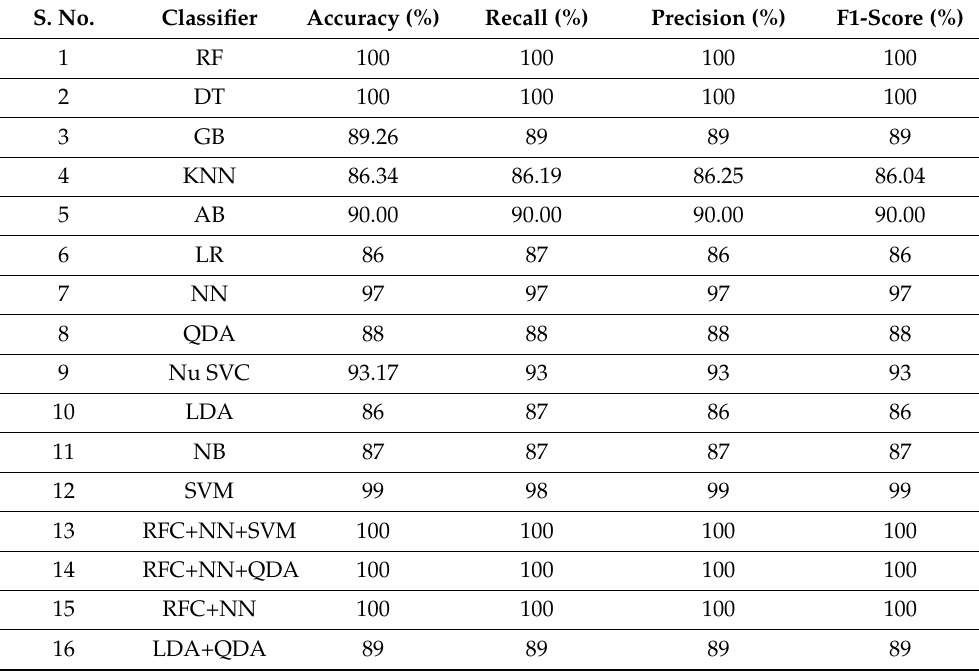
Table 5. Comparative study of the proposed method with existing method.